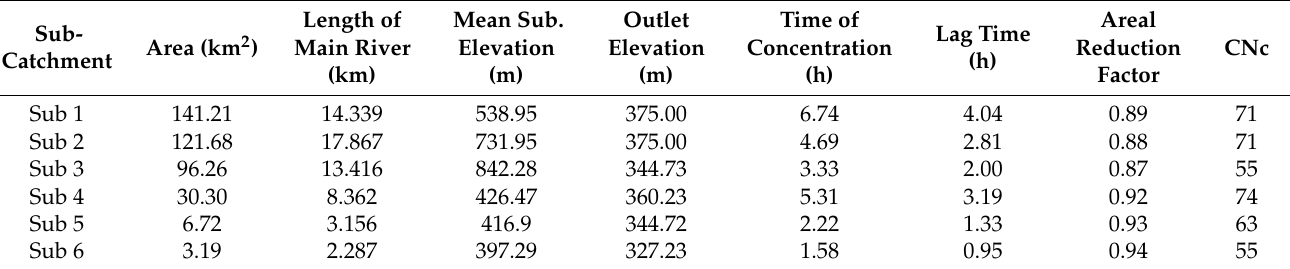
Figure 4. Digital Terrain Model of 2 m × 2 m resolution (DTM_2 m) of the study area (“hydro”) used for the delineation of the sub-catchments and hydrographic network (see SM2a and SM5). Table 1. The geomorphological features of all sub-catchment areas, together with the respective concentration times, lag times, and Areal Reduction factor